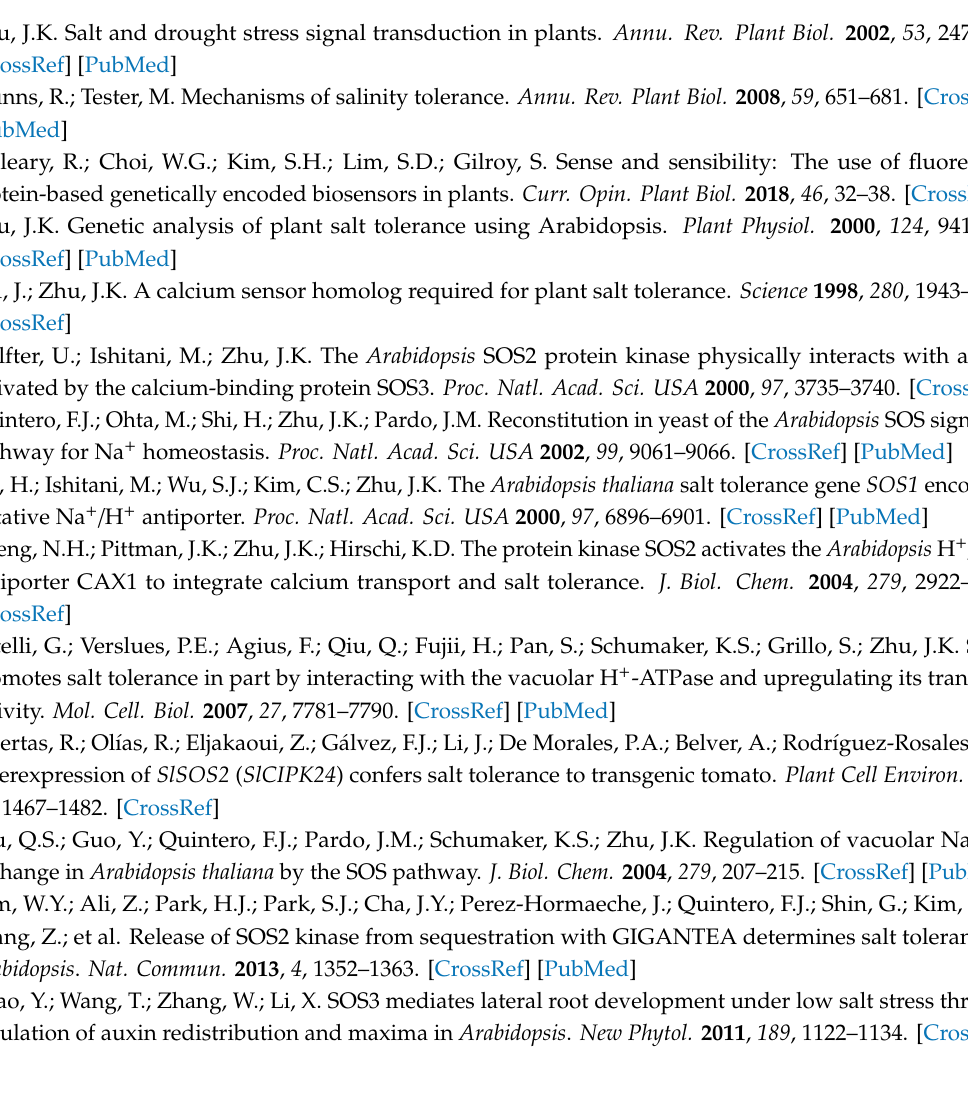
mutant plants under mild salt conditions. Figure S5: CBL10 and CBL4 shared several interacted CIPKs in common. Figure S6: CBL10-Venus fusion proteins were primarily targeted to intracellular membranes and can complement the salt sensitivity of the cbl10 mutant. Table S1: Primers used in this